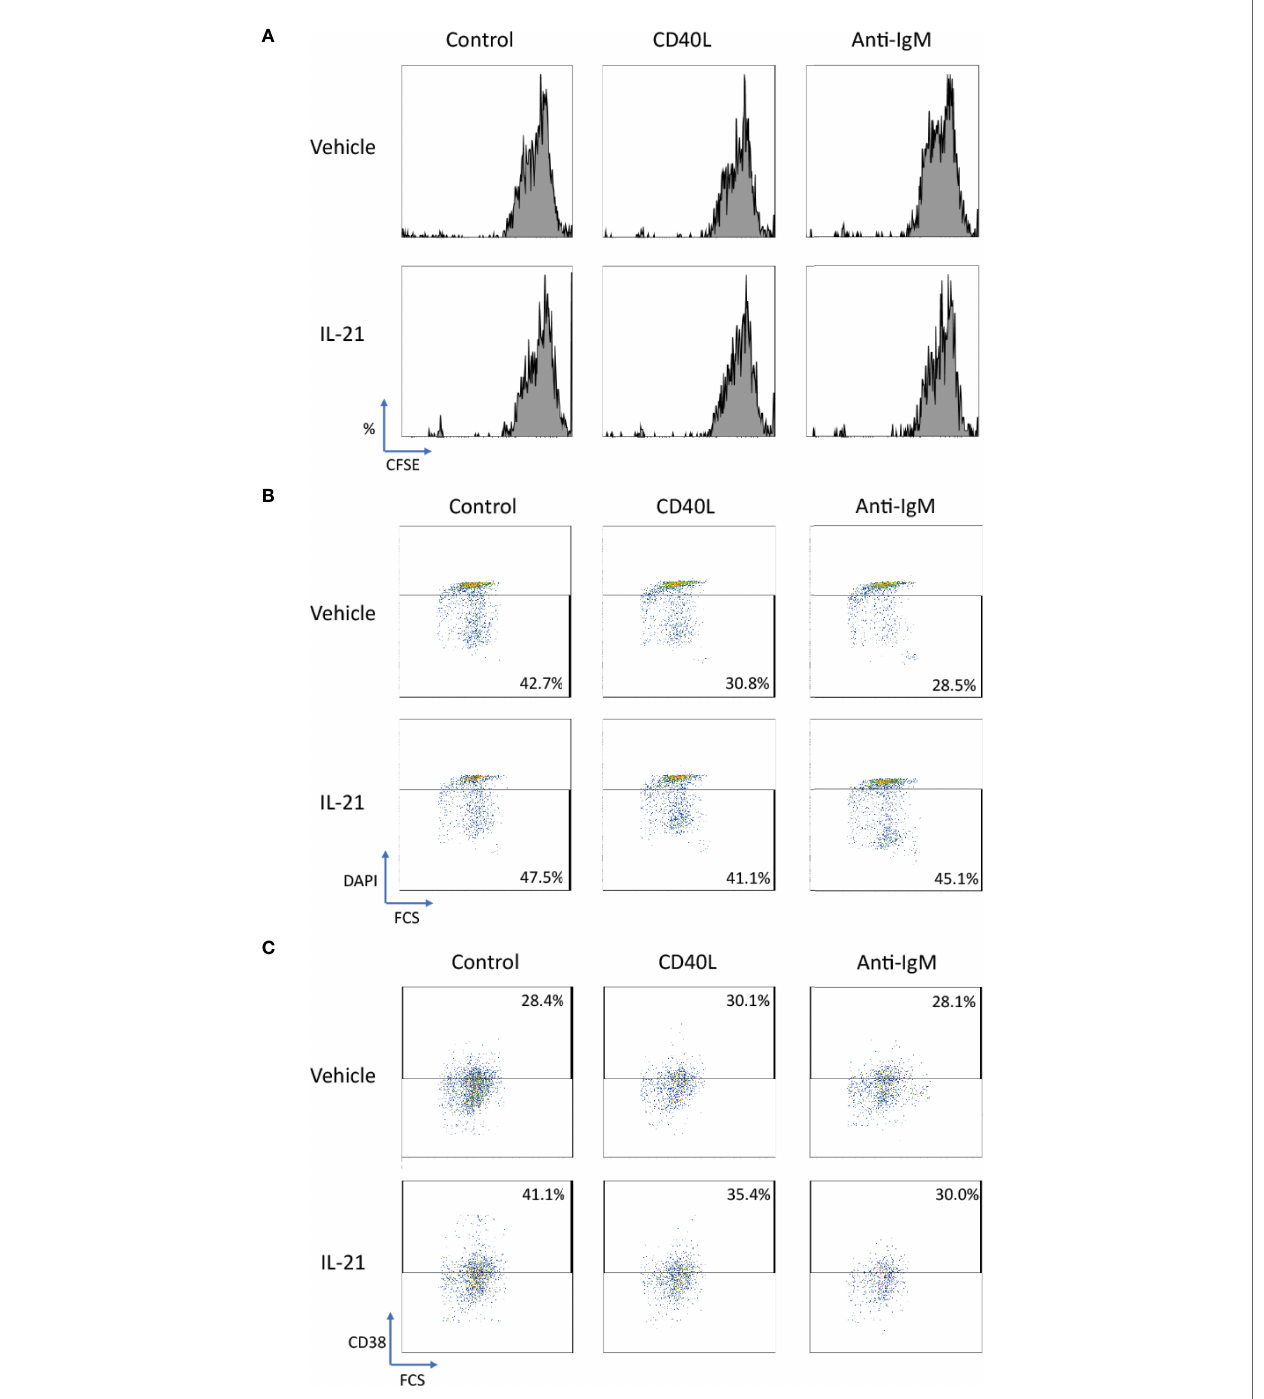
FIGURE 9 | IL-21 rescued CD40L and anti-IgM induced cell death in human primary B cells. (A) Representative graphs of CFSE labelling cells showed no differentiation was induced by any stimulatory factors in 3 days. (B) Representative graphs showed that IL-21 could suppress cell death induced by CD40L and anti- IgM in terms of increased number of DAPI- cells. (C) Representative graphs showed that IL-21 was able to induce CD38+ B cell differentiation both in the absence and presence of